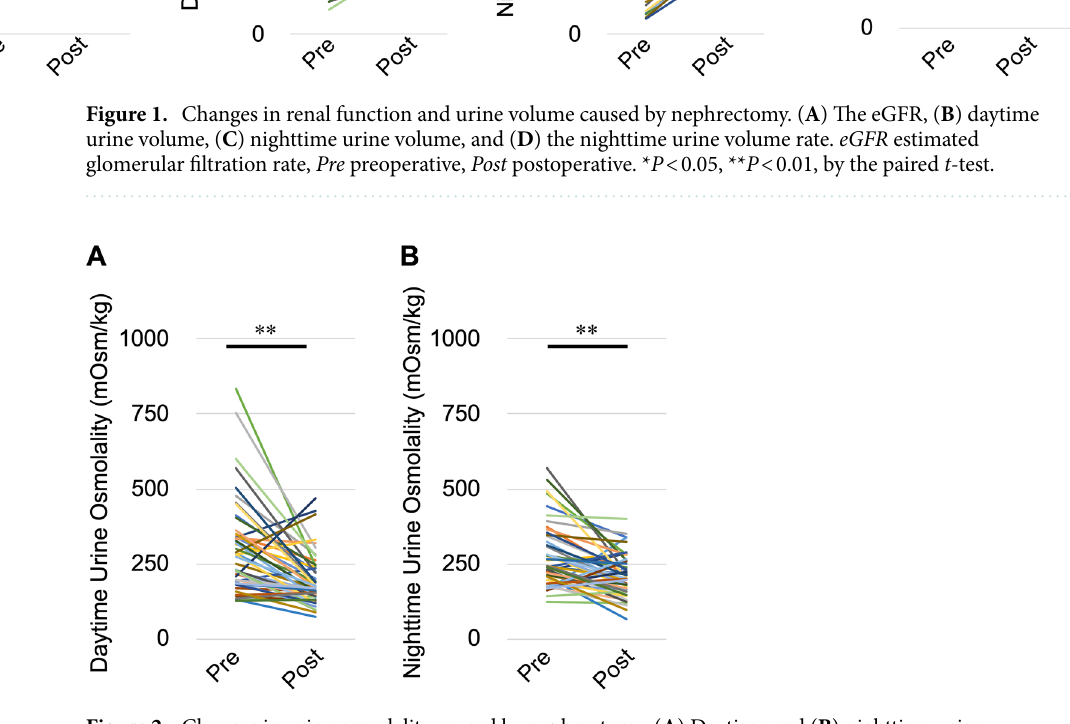
Figure 2. Changes in urine osmolality caused by nephrectomy. ( A ) Daytime and ( B ) nighttime urine osmolality. Pre preoperative, Post postoperative. ** P < 0.01, by the paired t